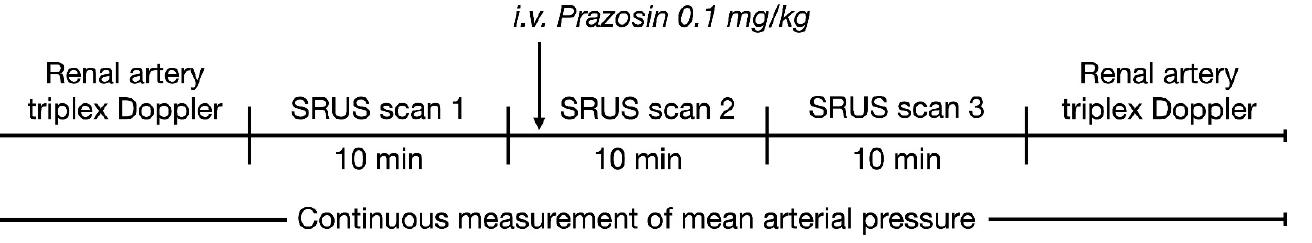
Figure 1. Timing of ultrasound scans and prazosin injection. Triplex Doppler included B-mode imaging, color Doppler, and spectral Doppler. i.v. = intravenous, SRUS = super-resolution ultrasound.